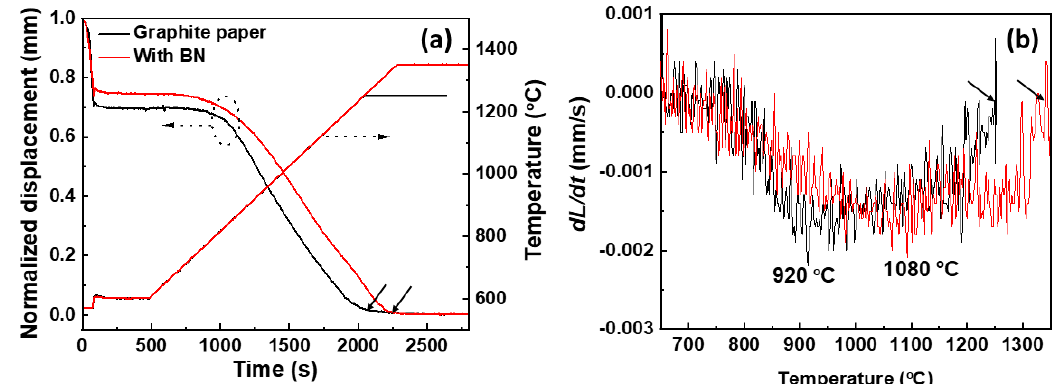
Figure 6. ( a ) Sintering temperature T and punch displacement L as functions of the processing time t, ( b ) densification rate (dL/dt) as a function of the sintering temperature T for the samples fabricated from the ball milled nanopowders under the conductive and insulation SPS set-up conditions; that is, for the conductive set-up, the both sides of the loaded powders were sandwiched by the electrical conductive graphite papers, whereas for the insulative set-up, those were sandwiched by the electrical insulator BN coating.